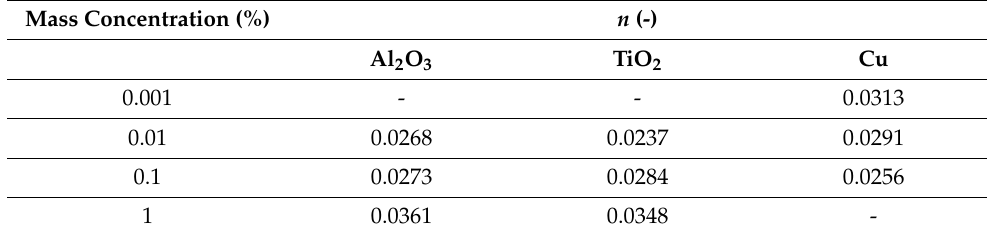
Table 4. Values of exponent n in Equation (14).